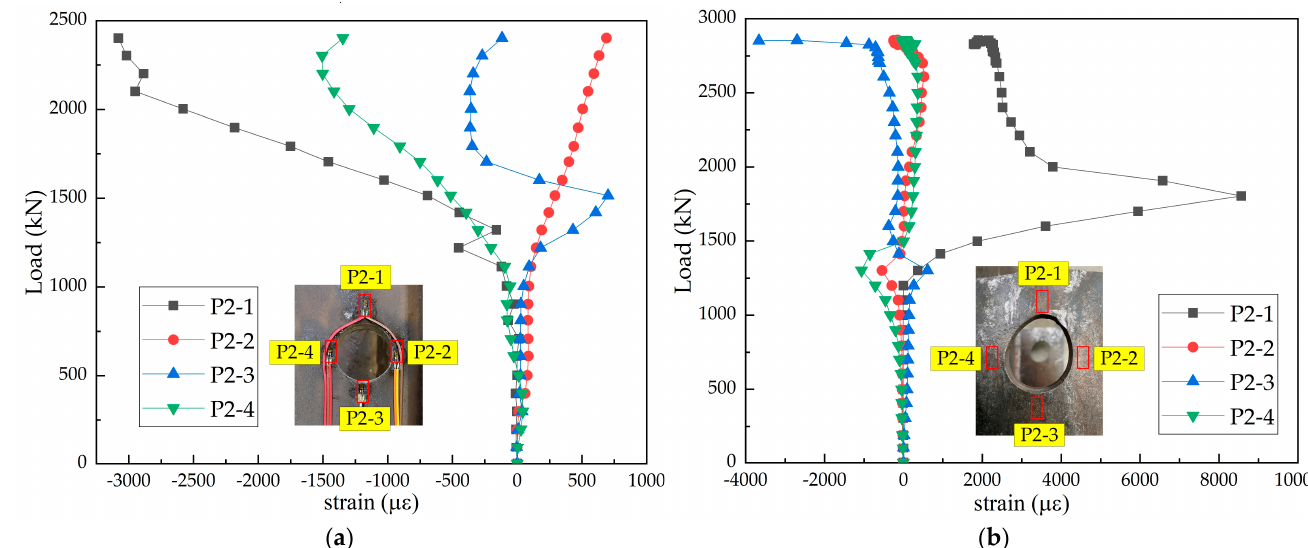
Figure 10. Load–strain curves of perforated steel plate: ( a ) N-16-3 and ( b ) S-16-3.